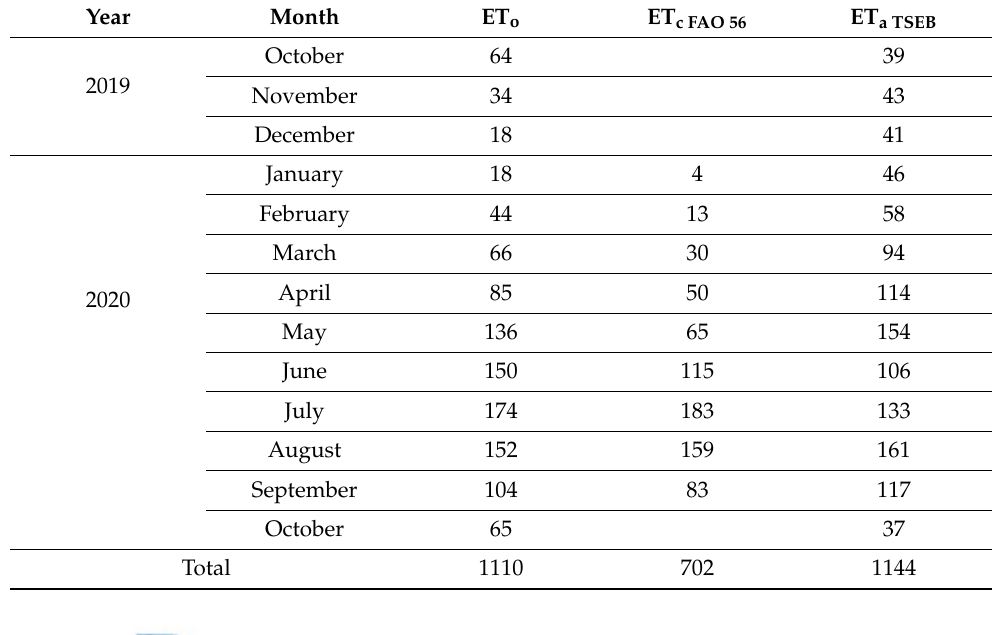
Table 9. Monthly mean values of ET o , ET c FAO56 and ET a TSEB in mm during the study period.